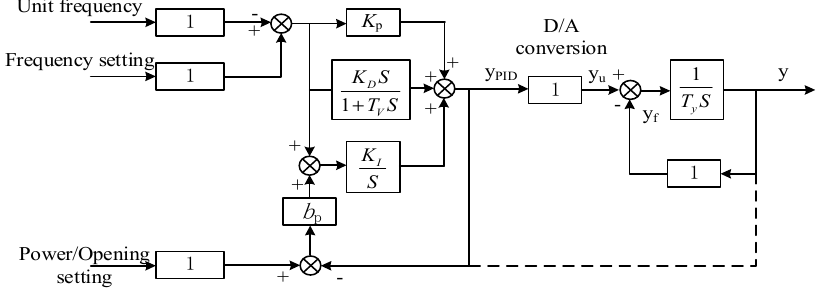
Figure 8. PID controller for the governor.